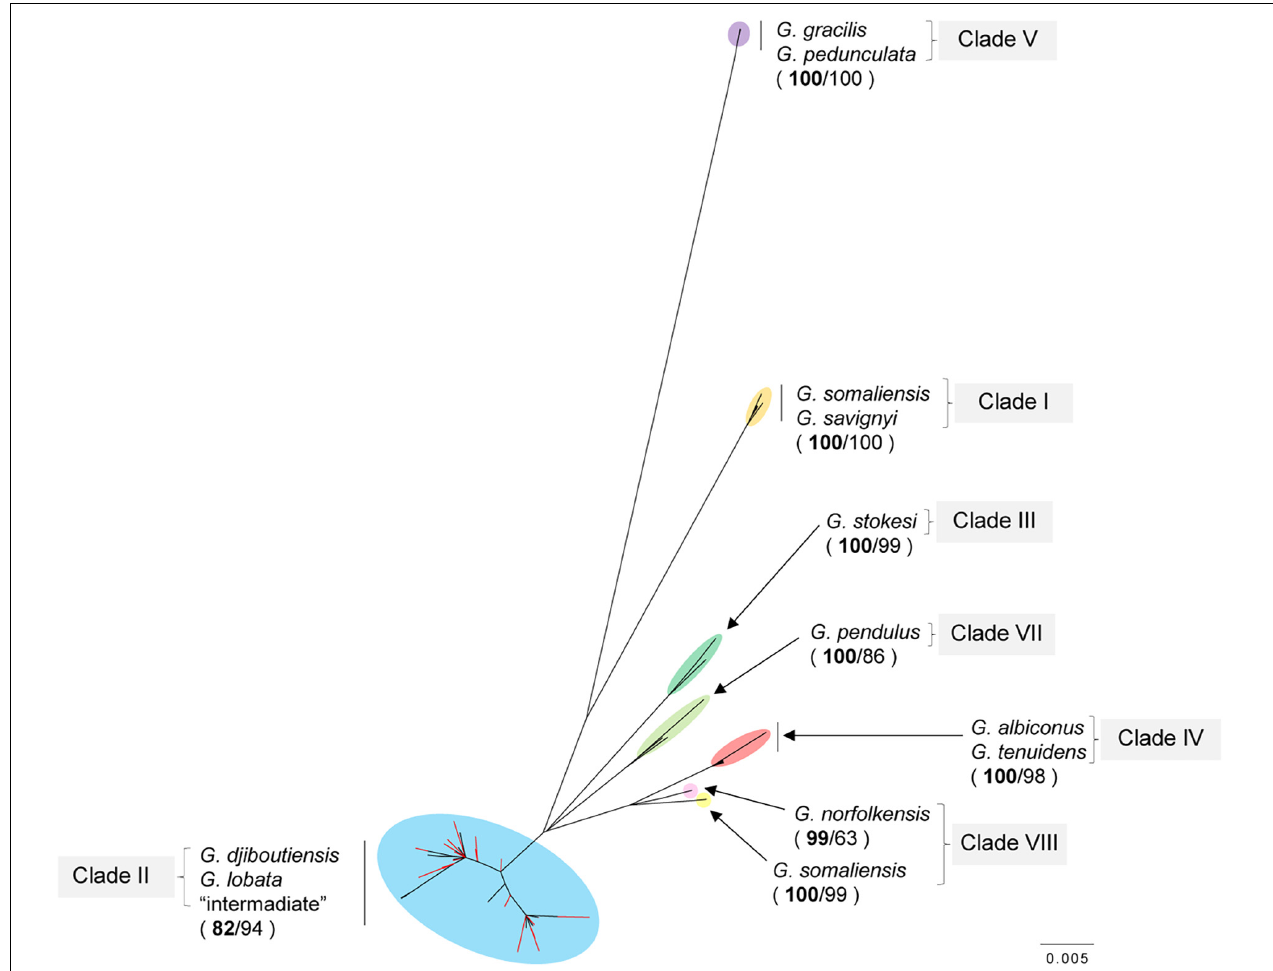
FIGURE 3 | Unrooted Maximum likelihood phylogenetic tree using internal transcribed spacer (ITS) regions including 44 reference sequences ( Goniopora somaliensis, G. savignyi, G. djiboutiensis, G. lobata, G. stokesi, G. albiconus, G. tenuides , G. pedunculata ( G. minor in Terraneo et al., 2016), G. gracilis, G. pendulus, and G. norfolkensisis ) taken from Terraneo et al. (2016). Clade names also correspond with those reported by Terraneo et al. (2016). Nodes in red colors represent the Japanese samples used in the present study. The values on each node represent bootstrap values for the ML and NJ methods. Bootstrap values from the ML method are shown in boldface. Scale bar shows 0.005 substitutions par site.